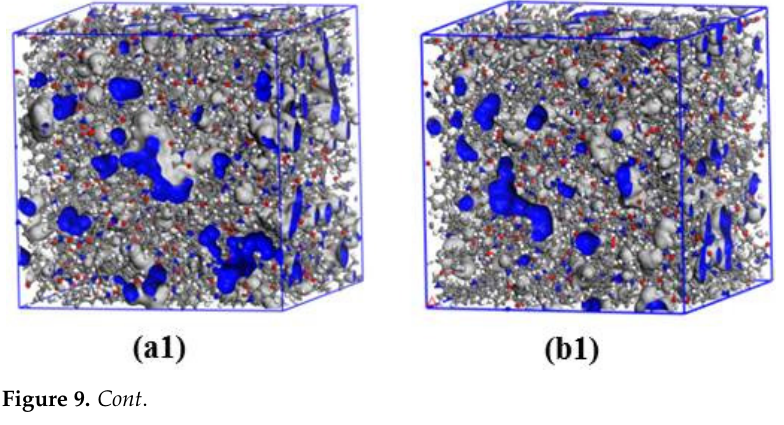
Figure 8. Distributions of void radius ( a ) and fractional free volume ( b ) as a function of probe ra- dius in M-2,7-CPPI and 2,7-CPPI. The kinetic radii of O 2 and H 2 O are indicated by vertical lines.